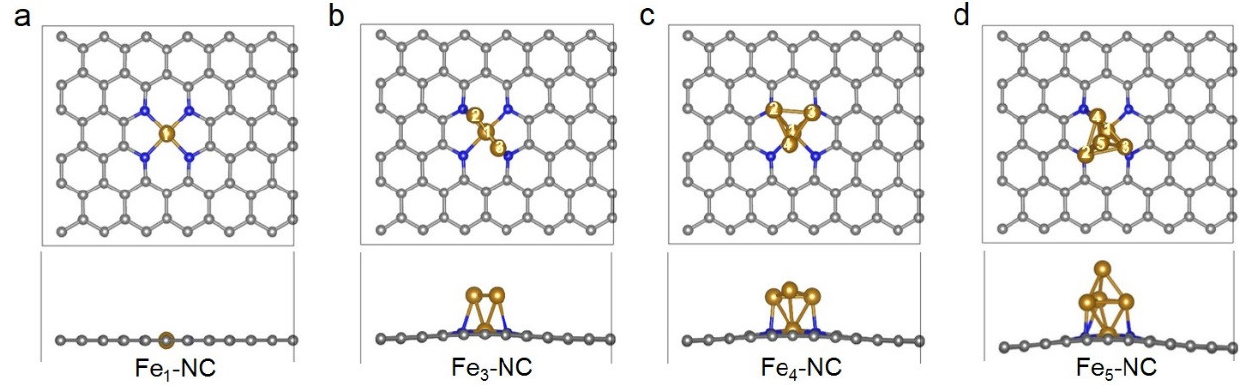
Figure 1. Top-view and side-view of optimized structures of Fe 1 ( a ), Fe 3 ( b ), Fe 4 ( c ) and Fe 5 ( d ) clusters supported on four nitrogen-doped carbon. The gold, blue and gray spheres represent Fe, N and C atoms, respectively. The different Fe sites are marked with white numbers.